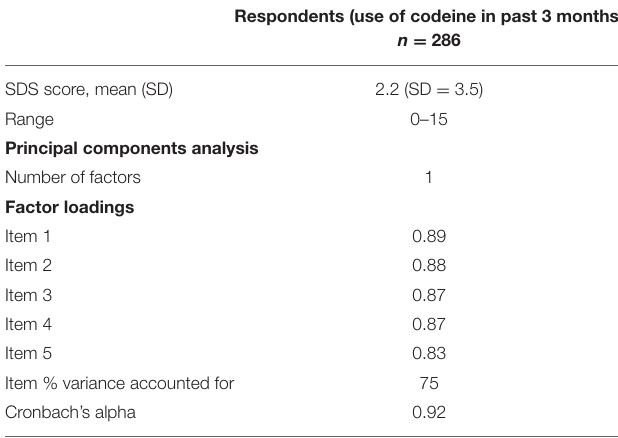
TABLE 2 | Factor loadings and percentage of variance accounted